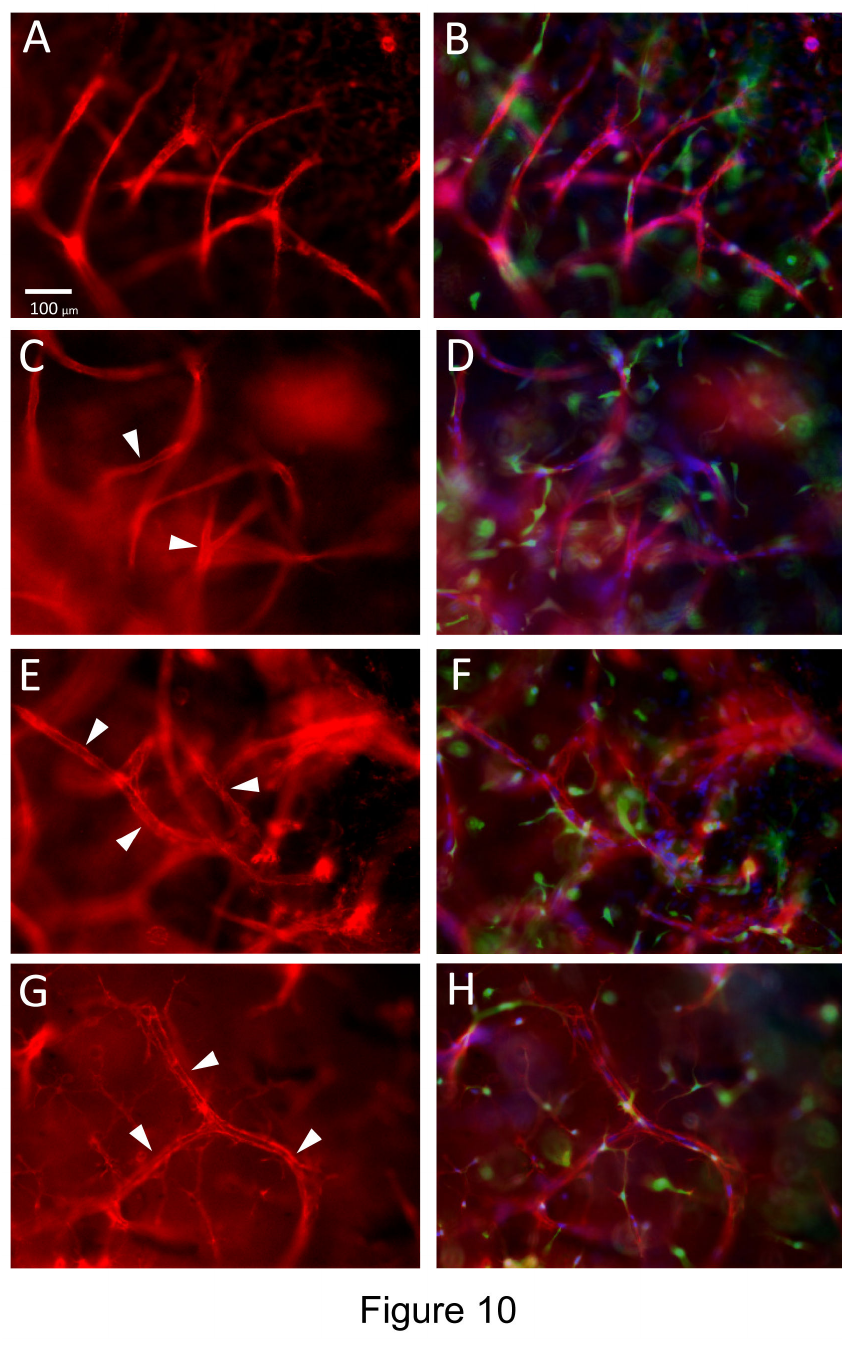
Figure 10. Pericytes recruit to invading EC sprouts/tubes and induce vascular basement membrane assembly on these EC tubes in 3D fibrin matrices under serum-free defined conditions. GFP-pericytes were seeded into 3D fibrin matrices which contained SCF, IL-3, SDF-1α, Flt-3L and FGF-2 while ECs were primed with VEGF/FGF-2 and then seeded on the surface of polymerized fibrin gels that contained growth factors and pericytes. ECs were allowed to sprout and form tubes for 120 hr prior to fixation and immunofluorescence staining with antibodies to CD31 (A,B); laminin (C,D); collagen type IV (E,F); or fibronectin (G,H). The basement membrane matrix antigens were stained in the absence of detergent to examine only extracellular deposition of these molecules. The right sided images (B,D,F,H) are overlay images for each stain showing the antigen stain in red, while GFP- pericytes are green and nuclei are blue (stained with Hoechst dye). Arrowheads indicate vascular basement membrane matrix deposition. Bar equals 100 µm. doi: 10.1371/journal.pone.0085147.g010 PLOS ONE |